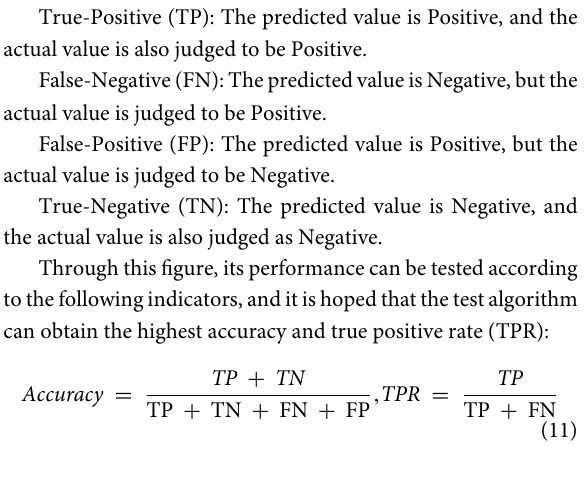
True-Positive (TP): The predicted value is Positive, and the actual value is also judged to be Positive. False-Negative (FN): The predicted value is Negative, but the actual value is judged to be Positive. False-Positive (FP): The predicted value is Positive, but the actual value is judged to be